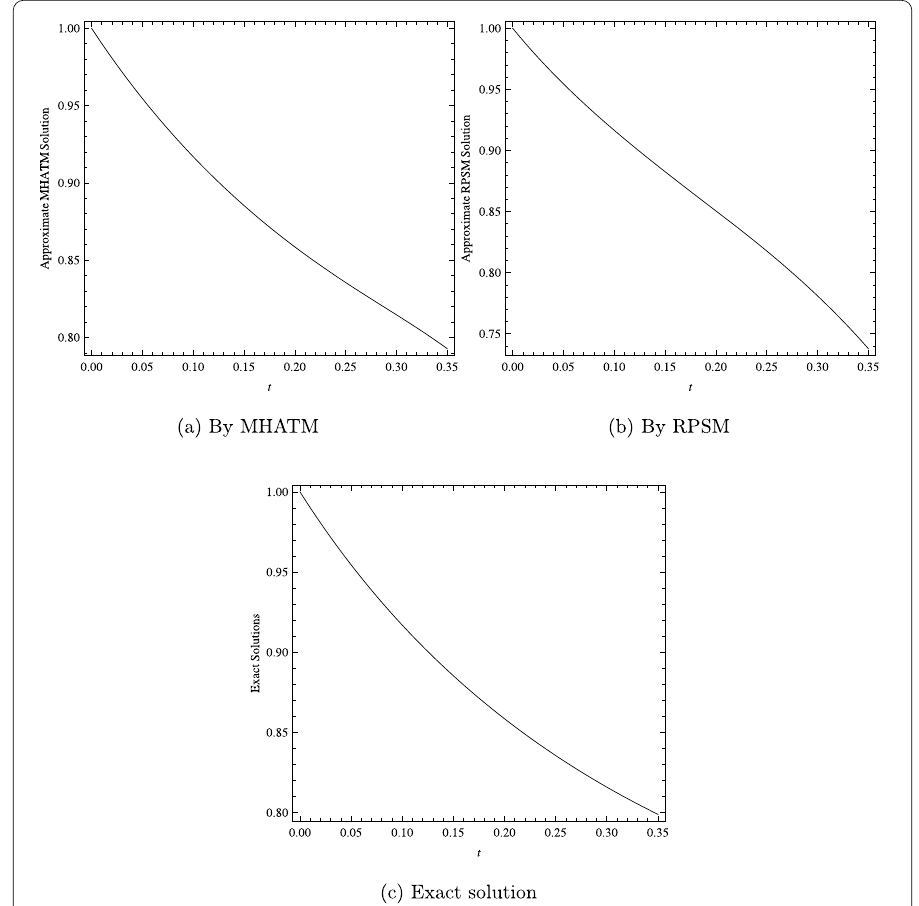
Figure 15 The surfaces show ( a ) the numerical approximate solution of η 4 ( x , t ) by MHATM when λ = 1, ( b ) the numerical approximate solution of η 4 ( x , t ) by RPSM when λ = 1, ( c ) the exact solution η ( x , t ) when λ = 1